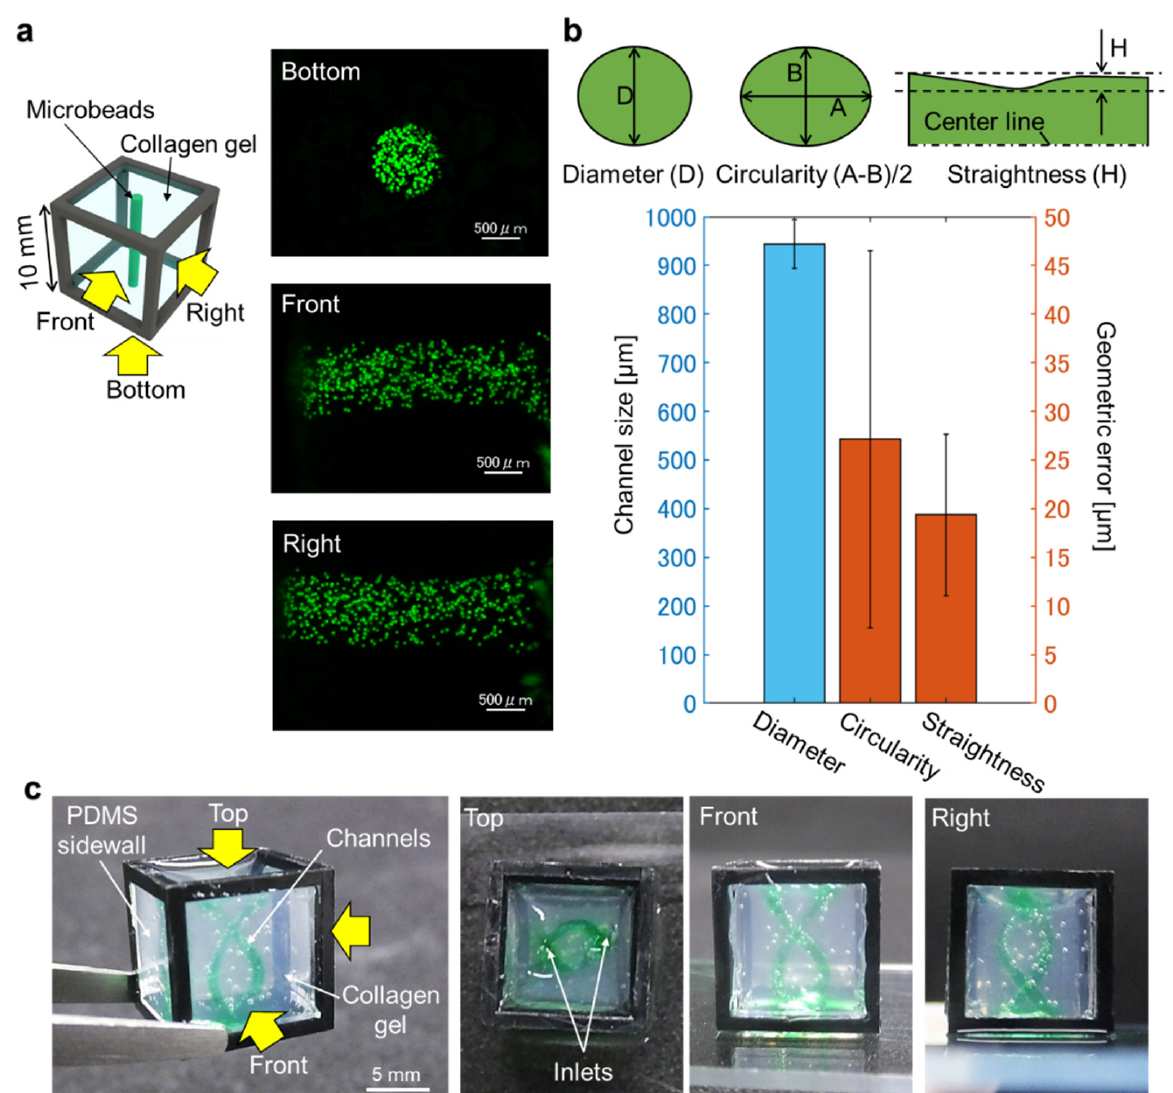
Figure 4. Measurement results of the collagen channel in 10 mm cube transferred from carbohydrate mold. ( a ) Schematic illustration and fluorescent images of the formed channel filled with fluorescent beads. The channel profiles were measured by scanning the filled microbeads from multi-directions. ( b ) Measurement results of the straight channel ( n = 5). ( c ) Demonstration of helix channel in a cube filled with collagen. Water with green dye was injected into the formed channel and multi-directional views revealed the whole shape of the helix channel. Error bars denote standard